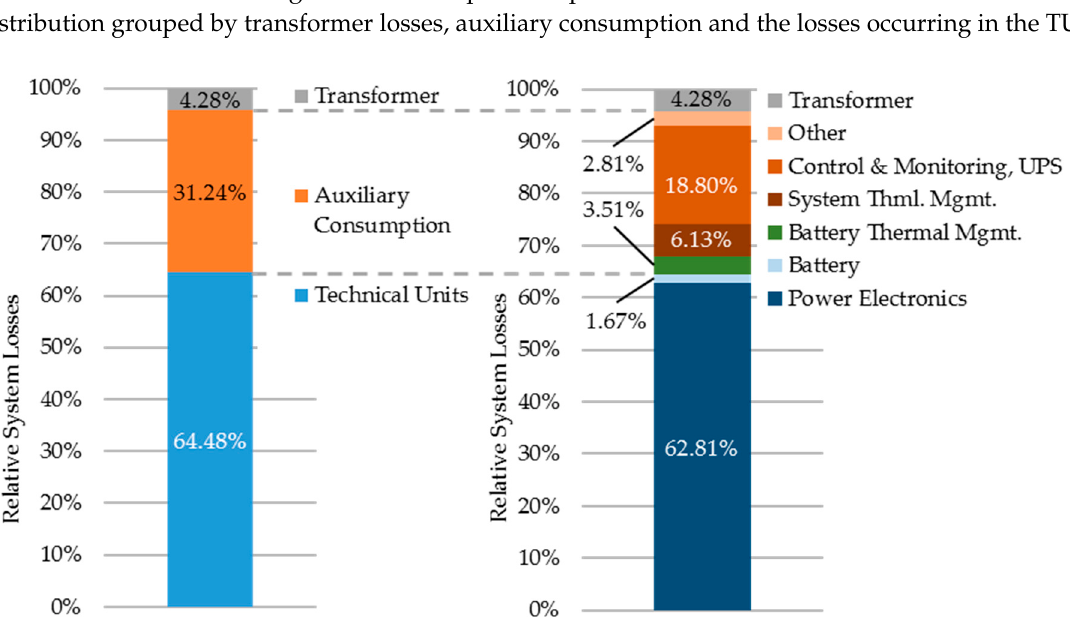
Figure 4. Overall system energy loss analysis based on model data for March 2017 for all units in operation for Primary Control Reserve/Intraday trading/Back-Up power.